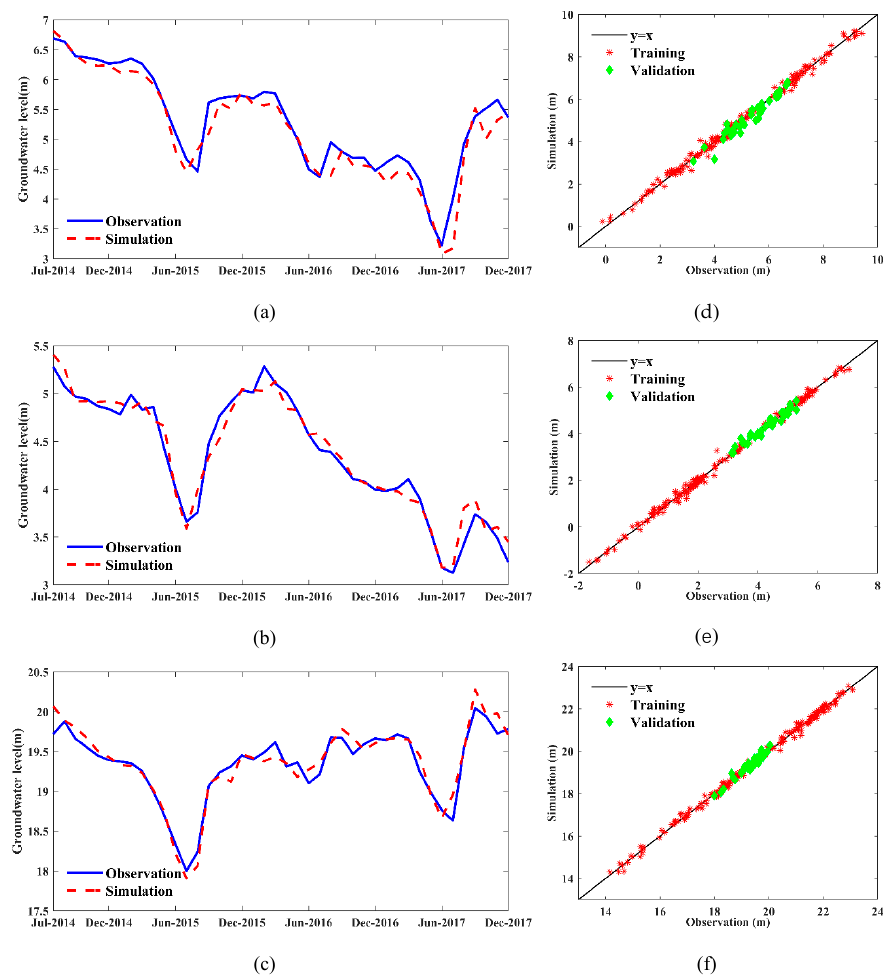
Figure 6. Comparison between observation and simulation of monthly average GWL using FNN Model 1: ( a – c ) Line plot of results in Zone1, Zone2, and Zone3 during validation period, respectively; ( d – f ) Scatter plot of results in Zone1, Zone2, and Zone3 during training and validation respectively. Table 2. Statistical indicators of FNN Model 1 performance during training and validation period.